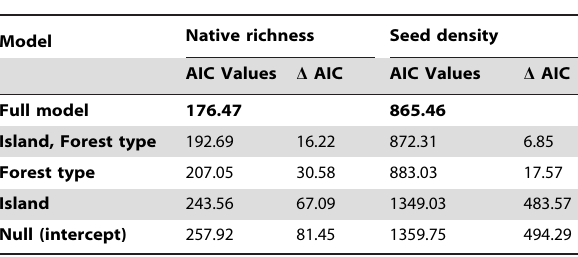
Table 3. Comparison of statistical models containing different combinations of Island and Forest type as explanatory variables for the richness of (column 1) and density (column 2) of seeds that come from native bird- dispersed